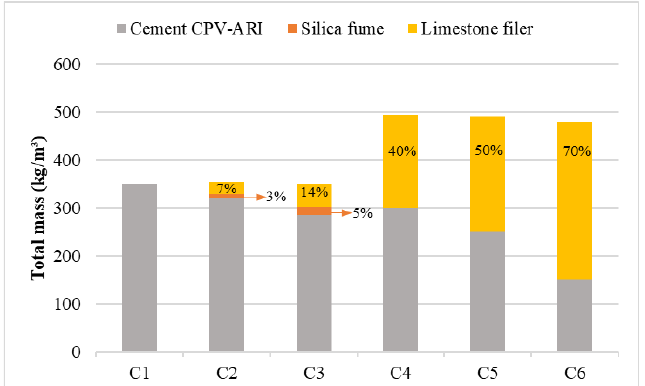
Figure 2. Amount of powder by mass per cubic meter in studied concretes. Percentages represent the filler and silica fume content by mass of powder.